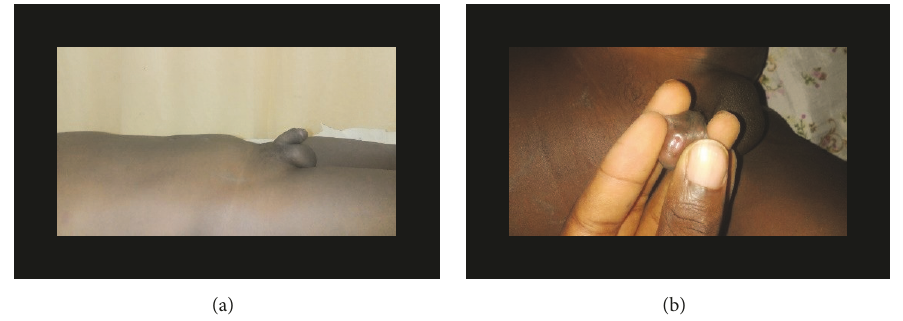
Figure 7: (a) Suprapubic bladder distension (case 2); (b) meatal stenosis (case